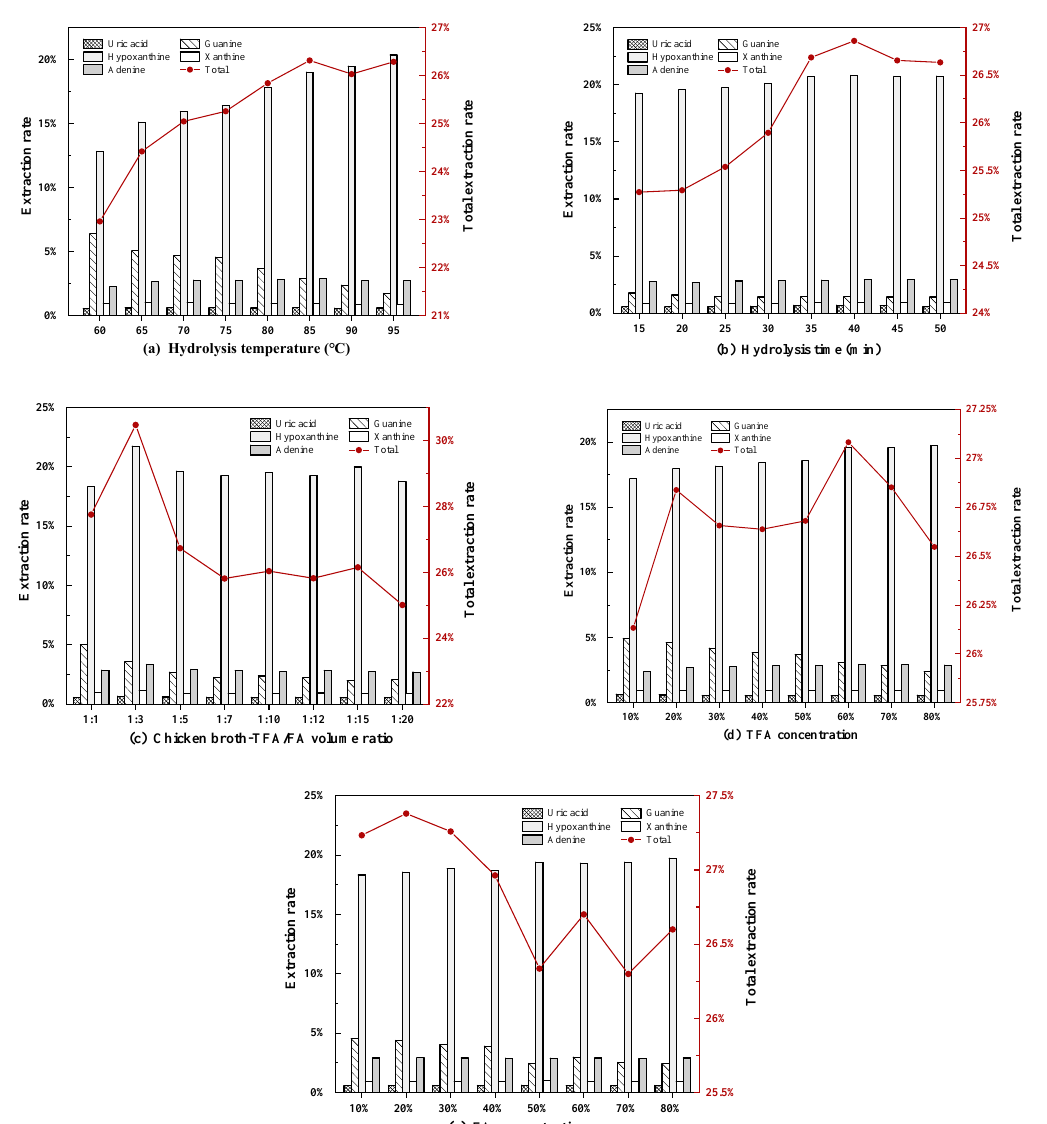
Figure 4. Effect of different factors on extraction rate using the trifluoroacetic acid/formic acid (TFA/FA) method. ( a ) Hydrolysis temperature; ( b ) Hydrolysis time; ( c ) Chicken broth-TFA/FA (1:1, v/v ) volume ratio; ( d ) TFA concentration; ( e ) FA concentration. The left vertical axis corresponds to the extraction rate of each analyte of adenine, guanine, hypoxanthine, xanthine and uric acid, and the right vertical axis corresponds to the total extraction rate of the five analytes.